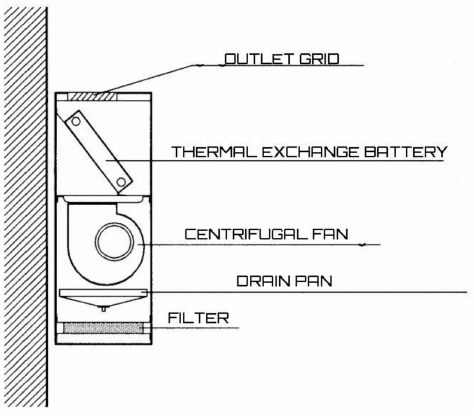
Figure 1. Fan coil structural elements.